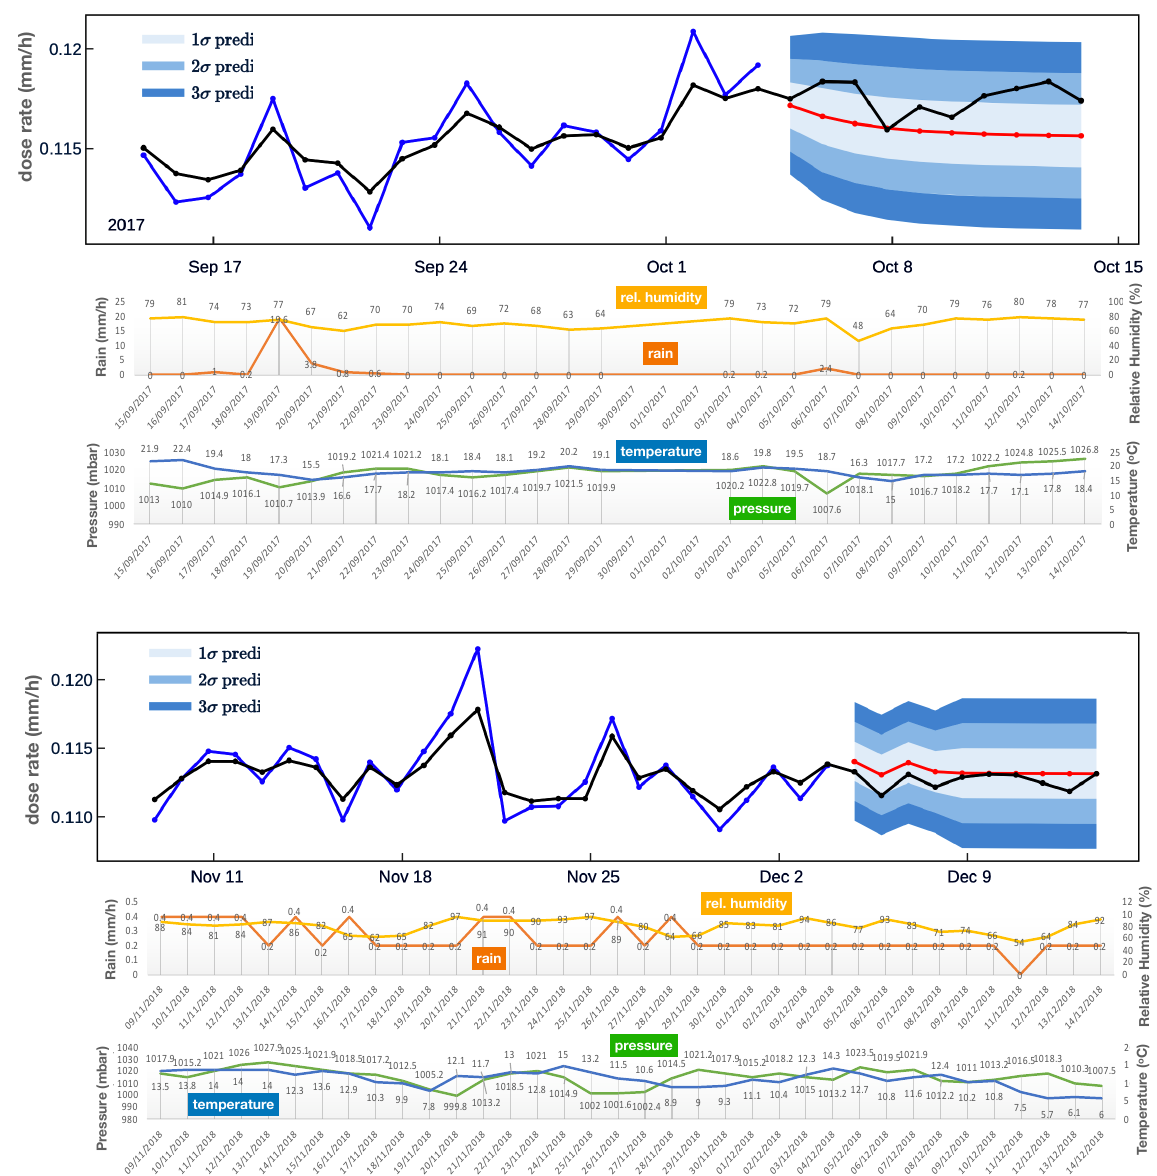
Figure 10. Typical results obtained for sub-series extracted from a long background-only series (color on-line). The first and third panels show the model results for two different data series. The black lines represent the collected dose rate data (daily average), the blue lines correspond to the the fits of the best ARFIMA models, and the red lines correspond to the model predictions. The confidence level bands for coverage factor k = 1, 2, 3 (from the lightest to the darkest blue) are drawn in the validation region. In the second and fourth panels the relative humidity, rainfall, temperature, and pressure time series are shown, as indicated by the respective